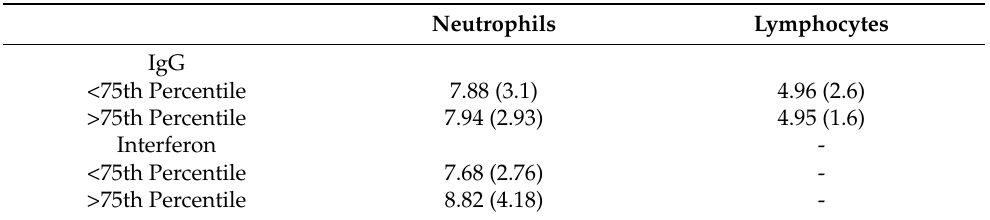
Table 8. Main values in neutrophils and lymphocytes counts according to IgG concentration ( p < 0.005).